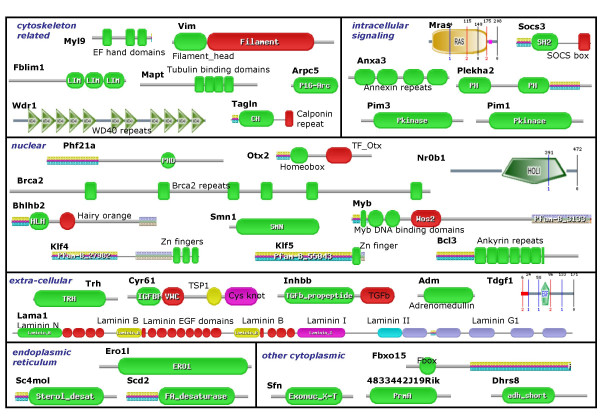
Domain organization of the 36 selected proteins. Illustrations are adapted from Pfam [67] or SMART [66]. Names close to or inside the domain pictures correspond to Pfam domain identifiers or, in the case of Tdgf1, Wdr1, Nr0b1, and MRas, to SMART domain identifiers. Three-coloured boxes correspond to Pfam-b domains that are automatically predicted. All sequences are at the same scale except Lama1.